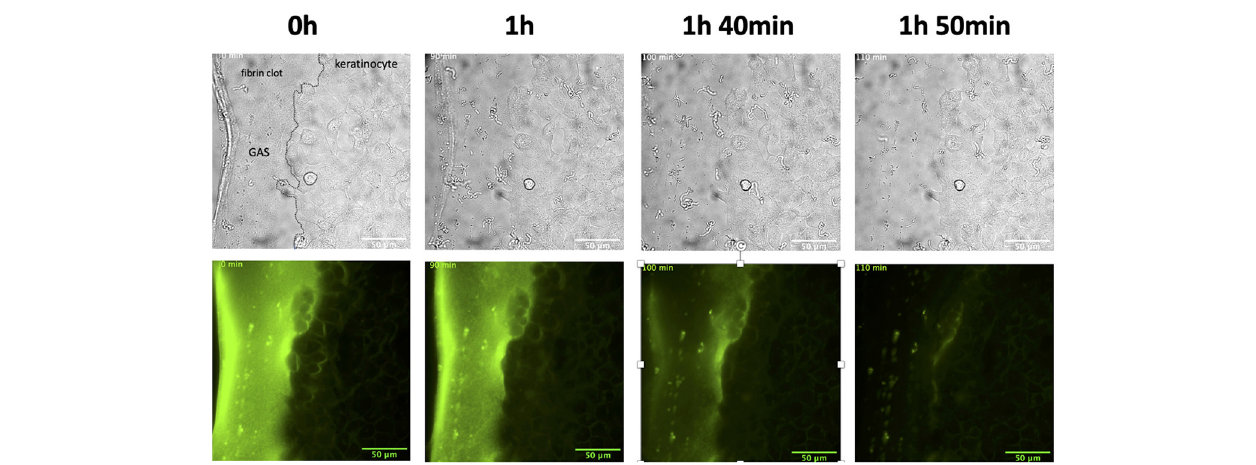
FIGURE 9 | The combination wound and clot model infected with AP53R + S − and hPg shows rapid fibrin clot dissolution in the presence of a keratinocyte wound. Prior to incubation with GAS, scratch wounds were produced as in Figure 1 and Fn was placed directly adjacent to the wound. The cells were then incubated with AP53R + S − at an MOI 5 along with the addition of 7 µ g/ml hPg prior to live imaging. Images were obtained every 10min for 10h for the duration of the imaging experiment. Time-lapsed images of the experiment are shown here (see Supplementary Video 7